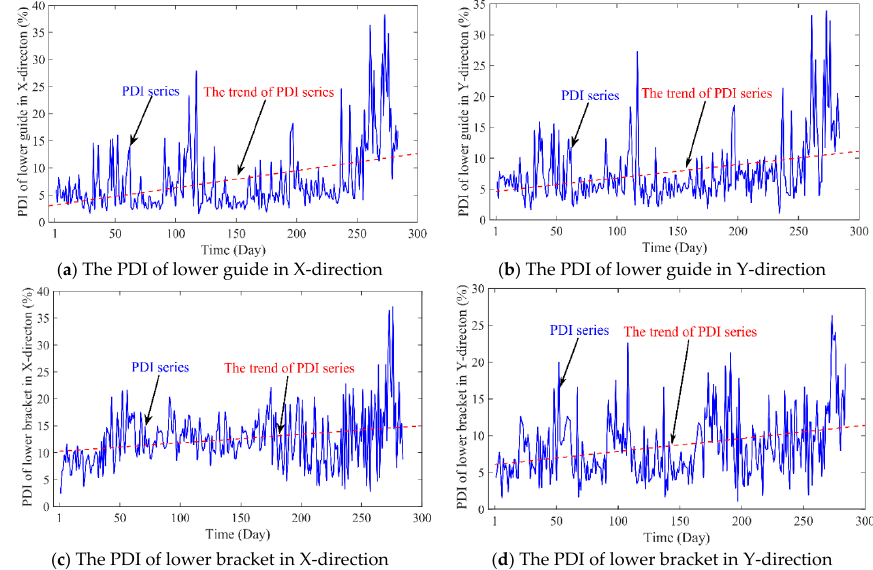
Figure 7. The PDI obtained from different objects: ( a ) the PDI of lower guide in X-direction, ( b ) the PDI of lower guide in Y-direction, ( c ) the PDI of lower bracket in X-direction, ( d ) the PDI of lower bracket in Y-direction.